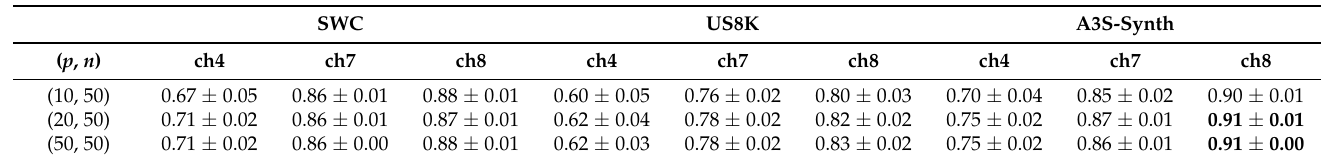
Table 9. A3S-Rec dataset: performance of the best prototypical models across all the recordings of channels 4-7-8 with harmonic filter. US8K